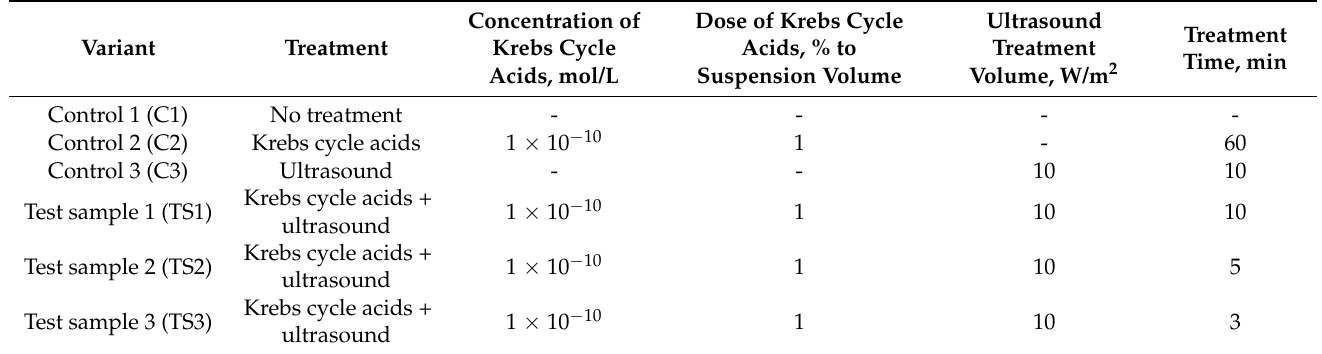
Table 1. Combined treatment of yeast with ultrasound and a mix of Krebs cycle acids: variants and